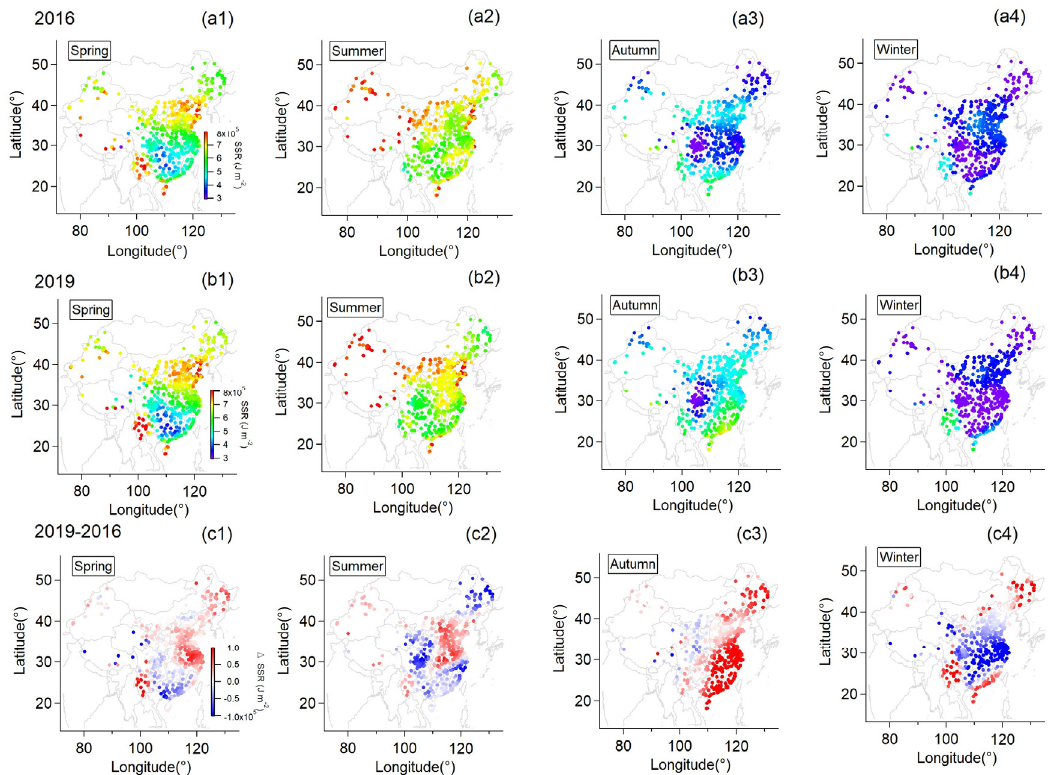
Figure 2. Seasonal mean of daily mean surface net solar radiation (SSR) for individual monitoring stations for 2016 ( a1 – a4 ) and 2019 ( b1 – b4 ); The difference in seasonal averaged daily mean surface net solar radiation between the two years ( c1 – c4 ). net solar radiation between the two years ( c1 – c4